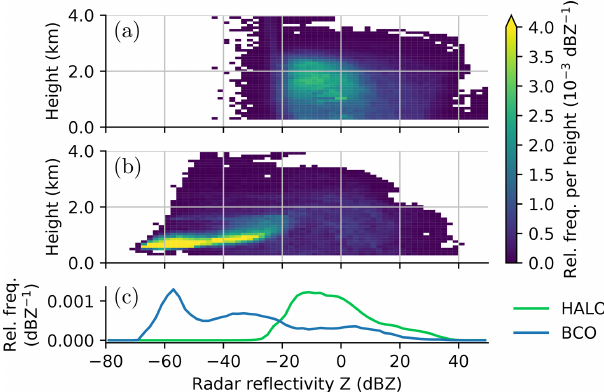
Figure A1. Height-resolved radar reflectivity distribution of shal- low cumulus from (a) HALO radar and (b) BCO radar during flight days of NARVAL-South. Marginal distributions (c) show the probability density of reflectivity from HALO and BCO below 4km. BCO data are limited to hours between 12:00 and 21:00UTC (08:00–17:00 local time) on every flight day to match aircraft oper- ation time. The probability density function of each height is nor- malized to the maximal possible number of data